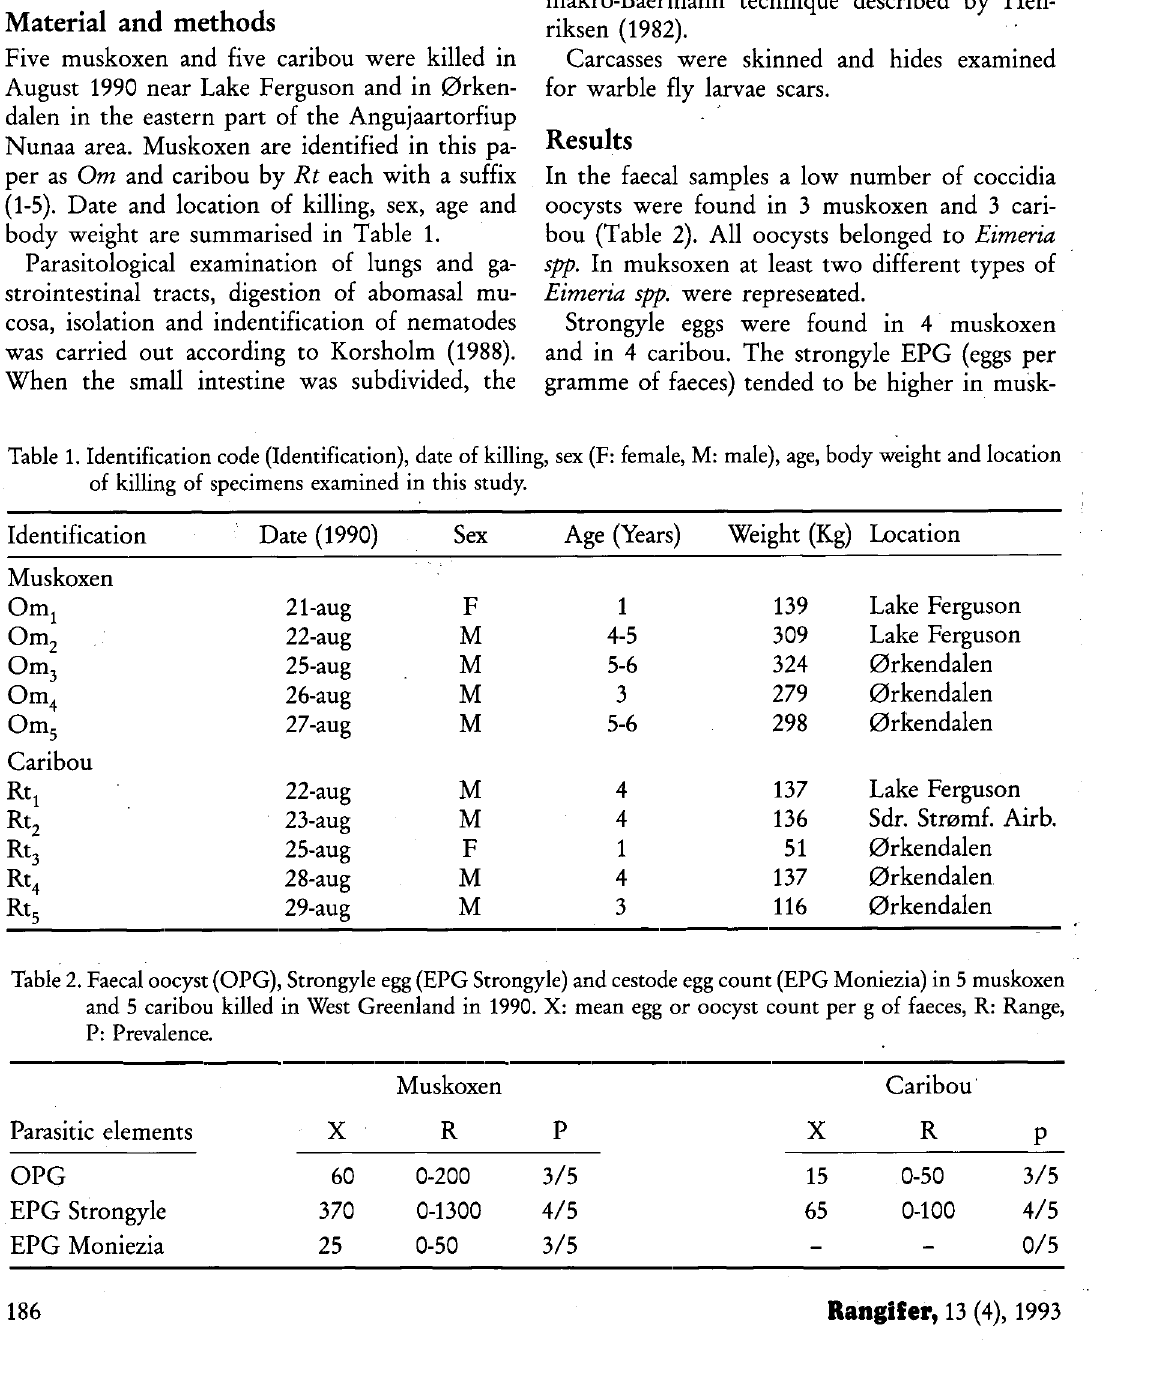
Table 1. Identification code (Identification), date of killing, sex (F: female, M: male), age, body weight and location of killing of specimens examined in this study.